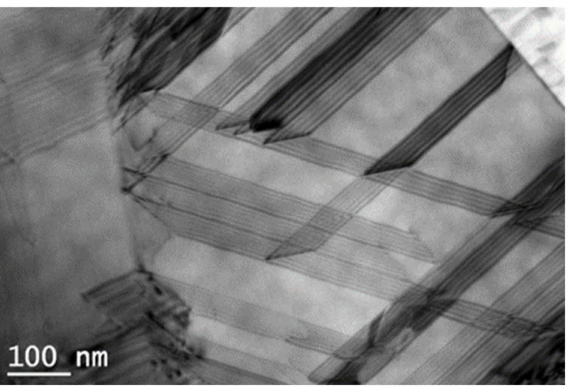
Figure 3. Stacking faults observed in the iron-based modules—processed by HSHPT (sample